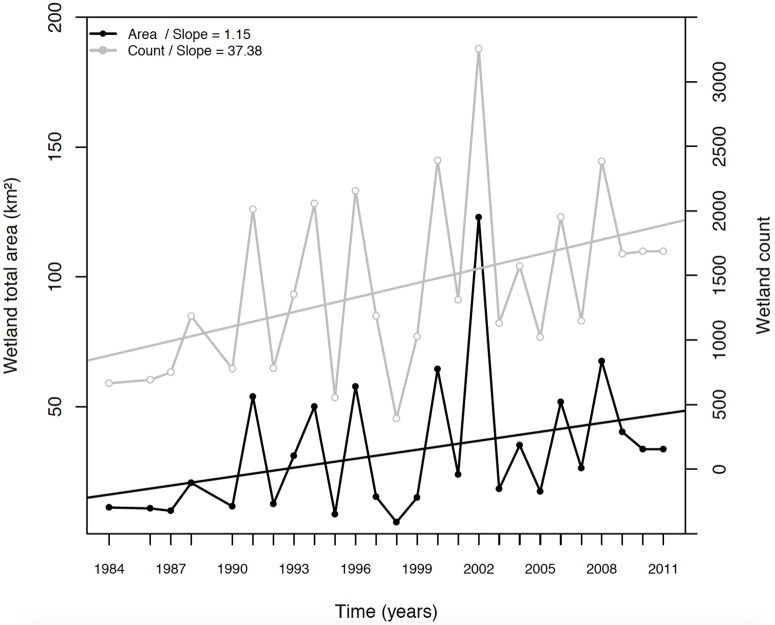
Changes in the total annual wetland surface area and wetland count over the 1984–2011 period in the Cordillera Real, Bolivia.The uncertainty in wetland cover calculations based on satellite images varies from a few km2 to 10 km2 depending on the year (see Methods).